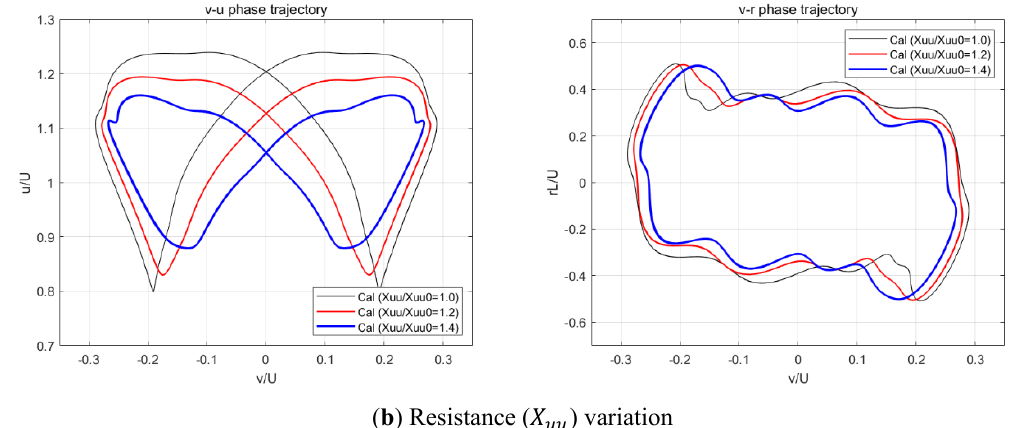
Figure 7. Phase trajectories of the towed vessel with hull force variations ( L T / L = 1.0).